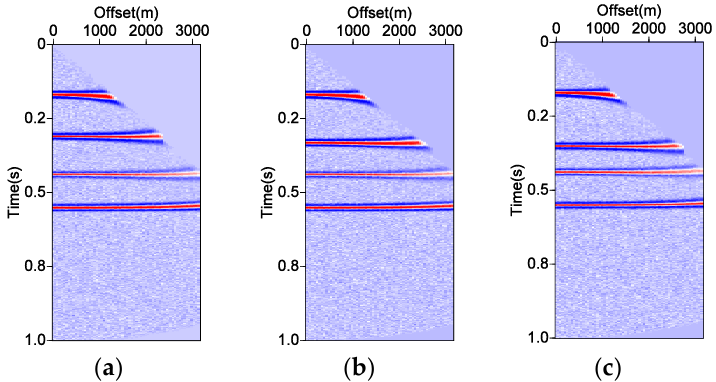
Figure 5. CDP gathers at different positions. ( a ) CDP 30; ( b ) CDP 50; ( c ) CDP 70.